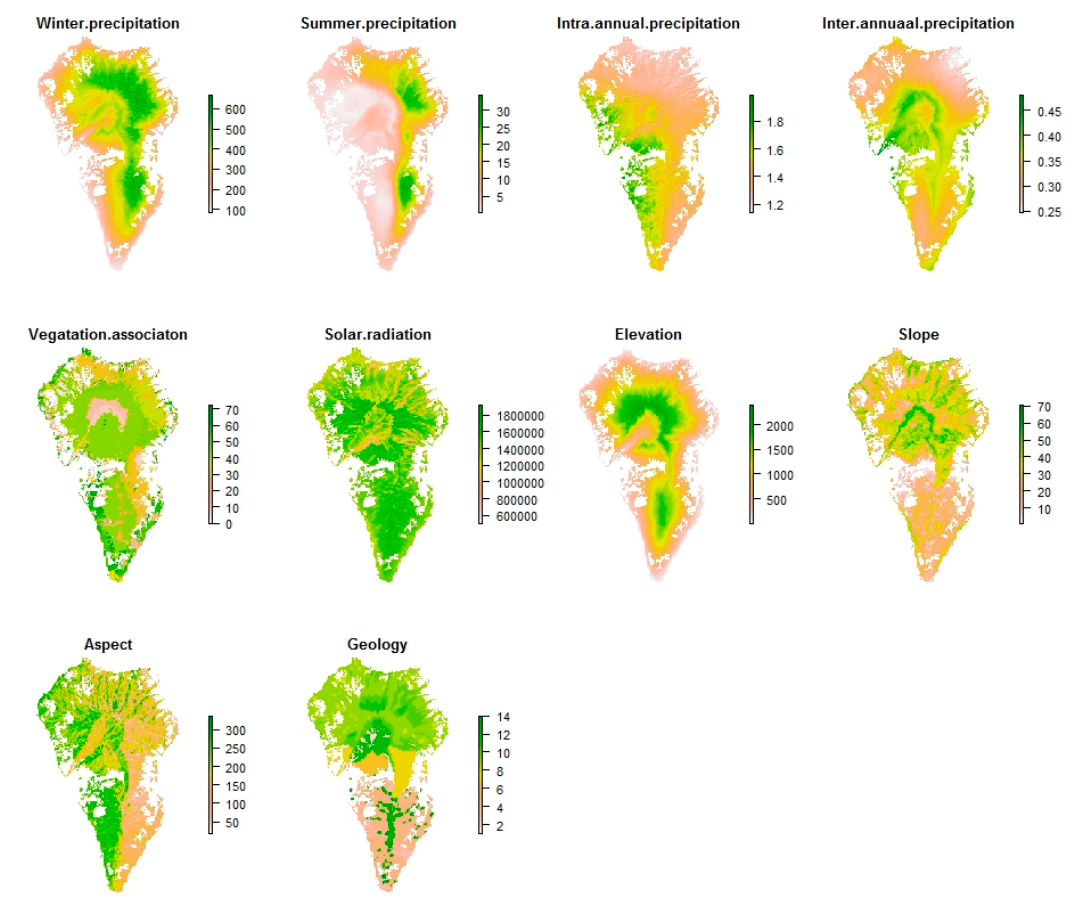
Figure A4. Environmental raster used in ecological niche modelling (ENM); Data surfaces are modified from data published in Irl et al., 2015.